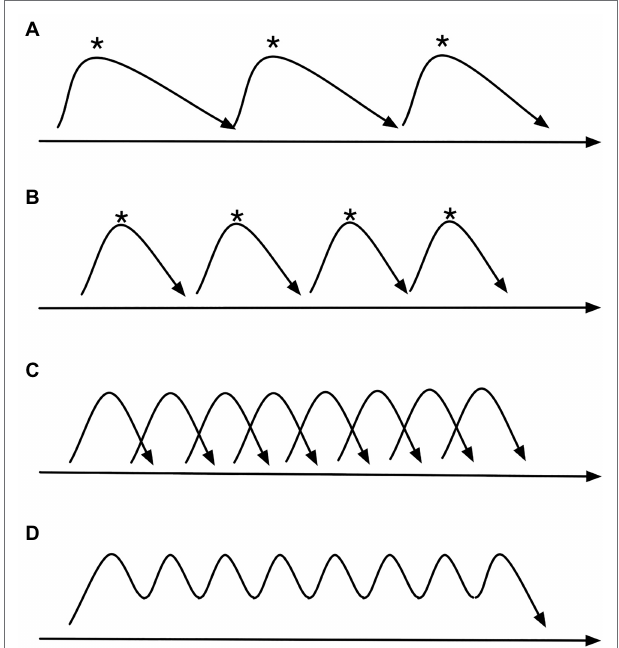
FIGURE 1 | A schematic image of emergent phase transition. If a series of separate motion events, each with a goal posture marked with an asterisk, lined up along a timeline from left to right such as in (A) , are moved closer together in time like in (B) , and even closer still, the events will fuse together like in (C) , becoming more like an iterative pattern where the originally separate events have become transformed into a rapid wavy motion like in (D)